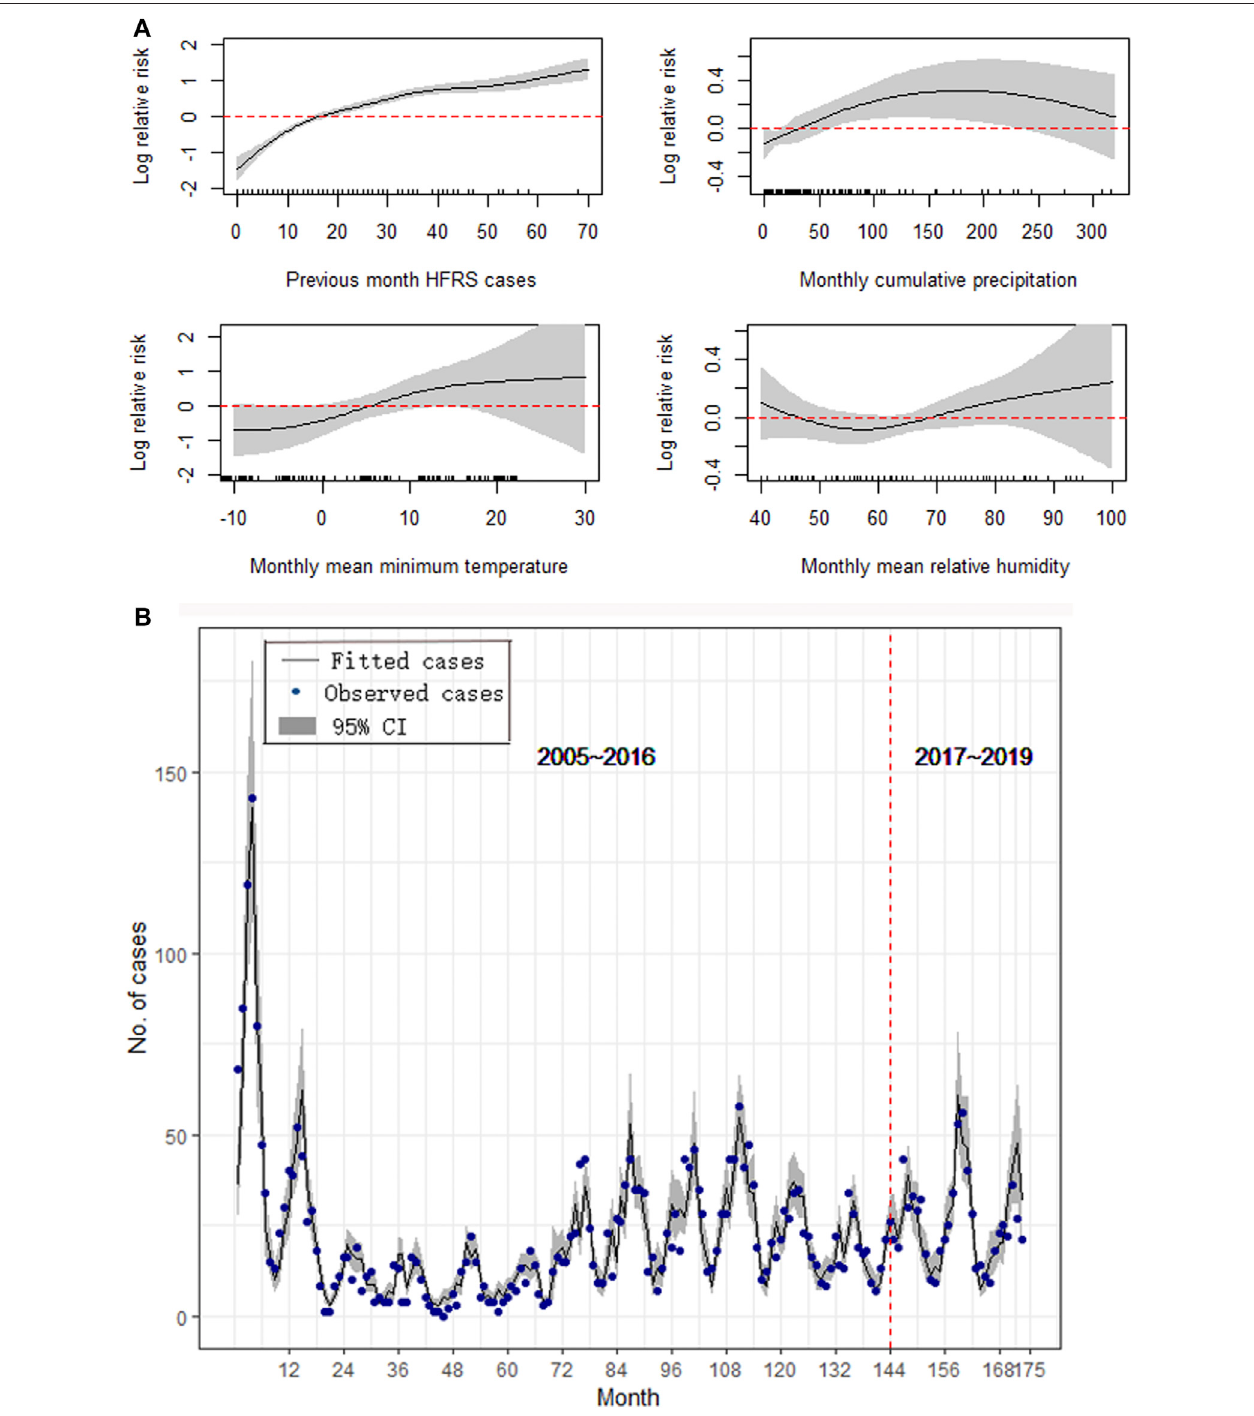
FIGURE 4 | Results of the GAM for Huludao. (A) The effect of meteorological on the epidemics of HFRS. (B) Forecast and comparison of the fi tted values.